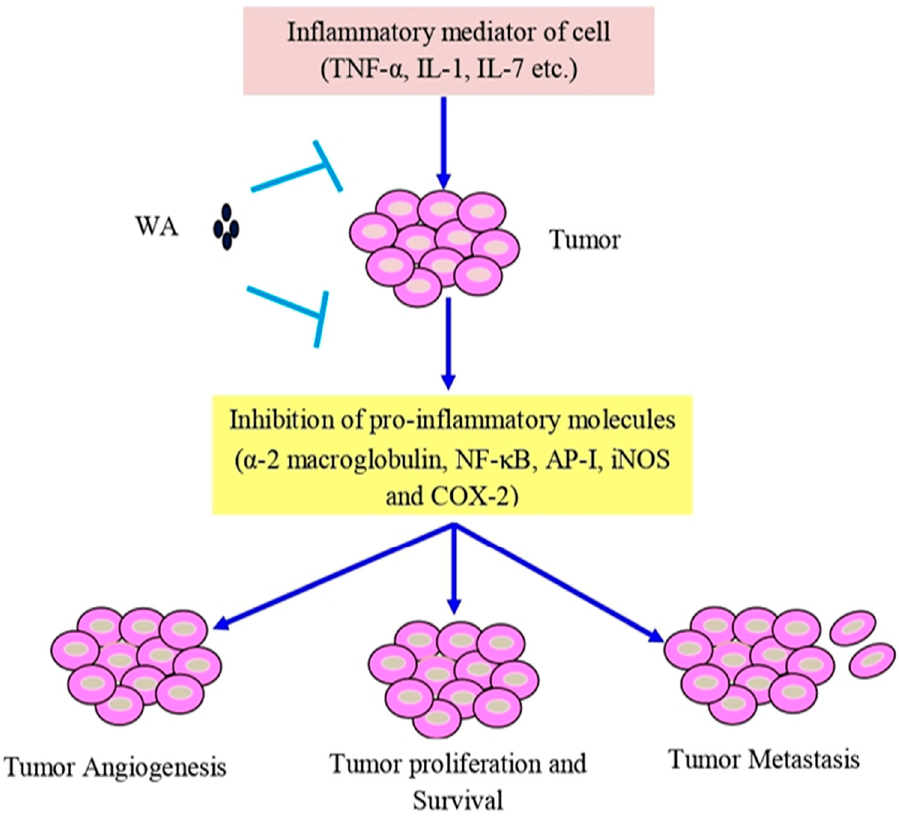
Figure 3. Withaferin A intercedes in anti-inflammatory function in tumor cells via TNF- α , IL-1, and IL-7. Abbreviations: IL-1, interleukin-1; IL-7, interleukin-7; and TNF- α , tumor necrosis factor- α .